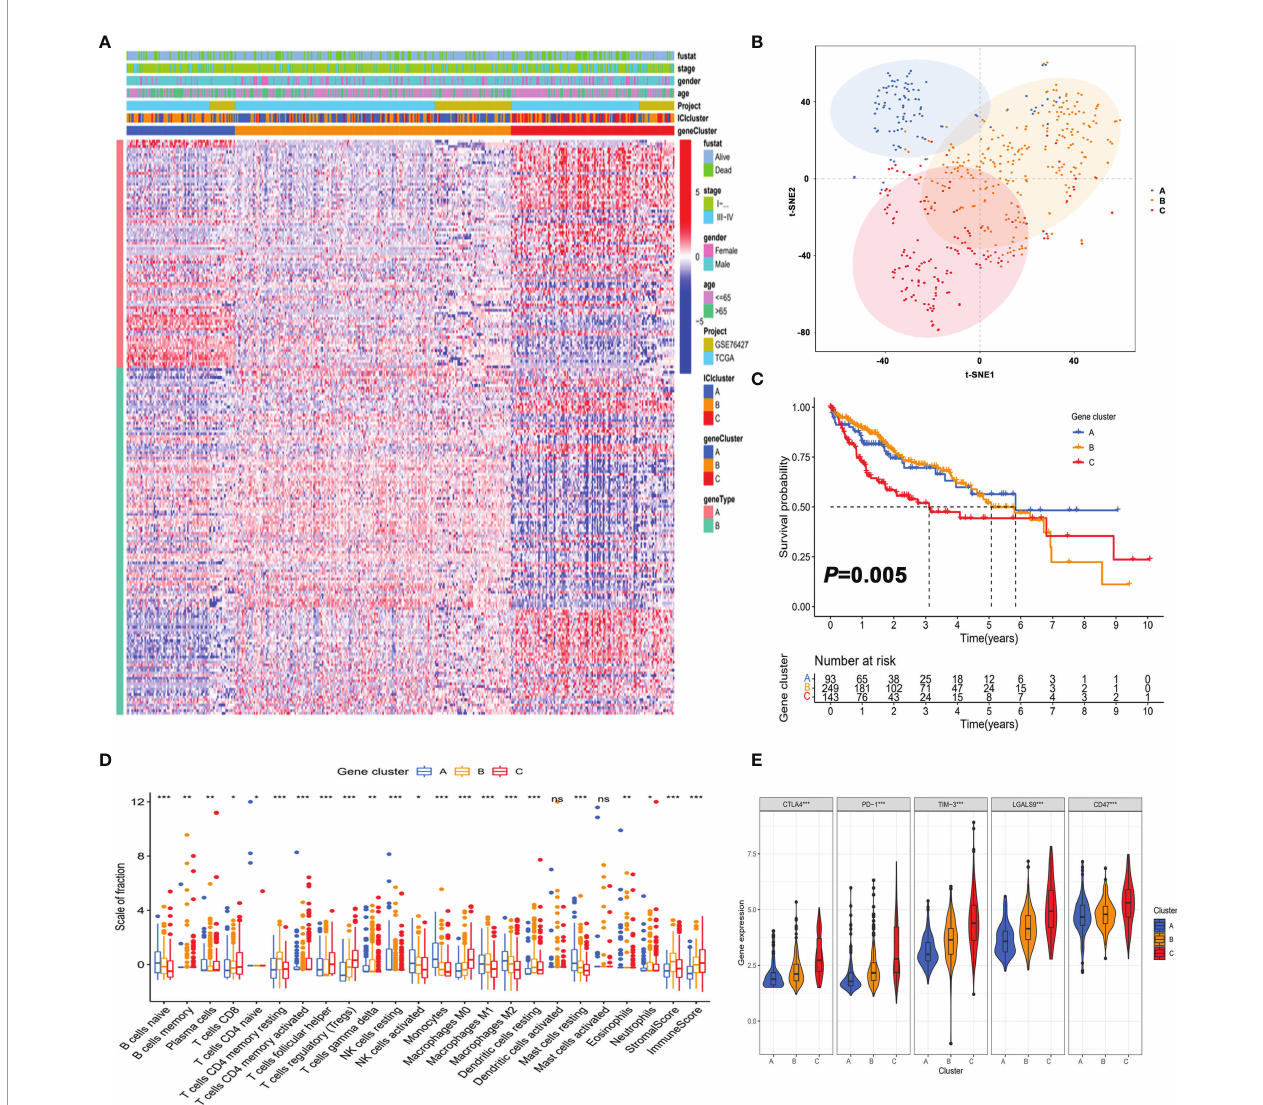
FIGURE 3 | Identi fi cation of gene subtypes of HCC based on immune pro fi les. (A) Unsupervised clustering of differential gene expression among three immune in fi ltration clusters. (B) Con fi rmation of the clustering patterns using the t-SNE algorithm. (C) Kaplan – Meier curves for patients in the three clusters with log-rank p = 0.005. (D) Comparison of the proportion of tumor-in fi ltrating immune cells in three gene clusters. * p < 0.05; ** p < 0.01; *** p < 0.001; ns, not signi fi cant. (E) Comparison of the expression of immune checkpoints among distinct immune in fi ltration clusters. * p < 0.05; ** p < 0.01; *** p <